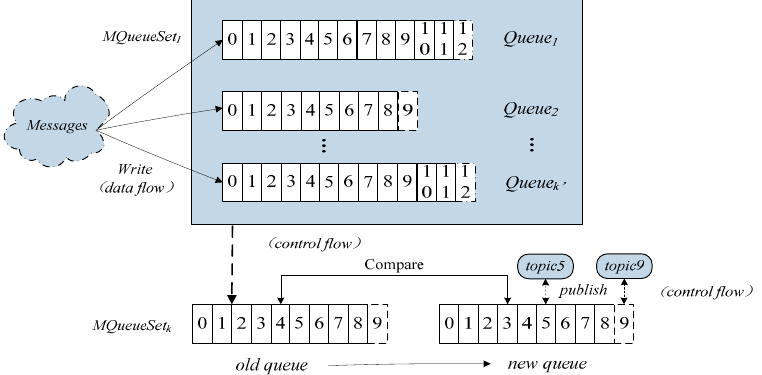
Figure 2. Model of predictive message scheduling.